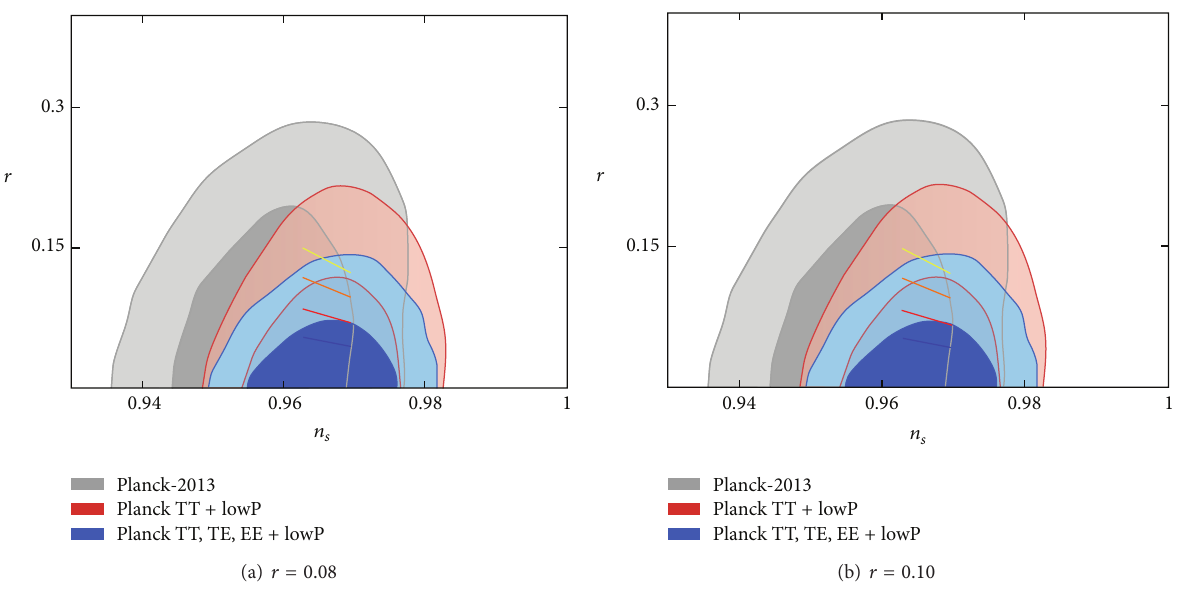
Figure 5: The figure shows the tensor-to-scalar ratio versus the scalar spectra index.